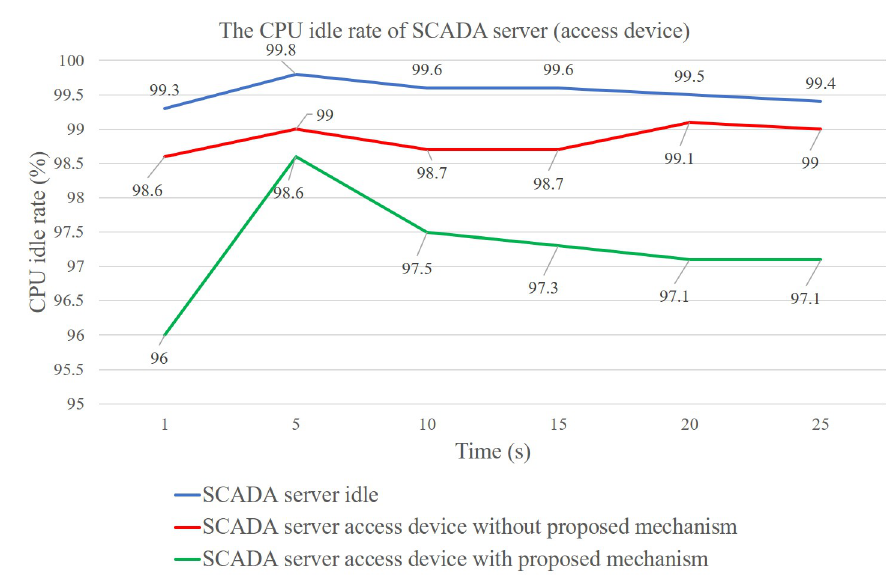
Figure 11. Performance comparison without DoS attack.